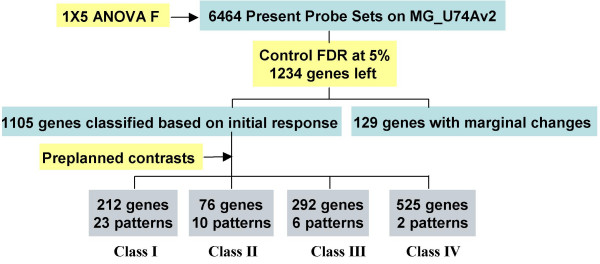
Flow chart illustrating the statistical procedure to classify gene expression patterns. A 1 × 5 ANOVA F test was performed for each of the 6464 genes after data filtering. By controlling FDR at 5%, 1234 genes were selected, 1105 of which were clustered into 4 classes based on the timing of their initial significant change in expression level. The fluctuation patterns of genes in each class were examined using planned linear contrasts.